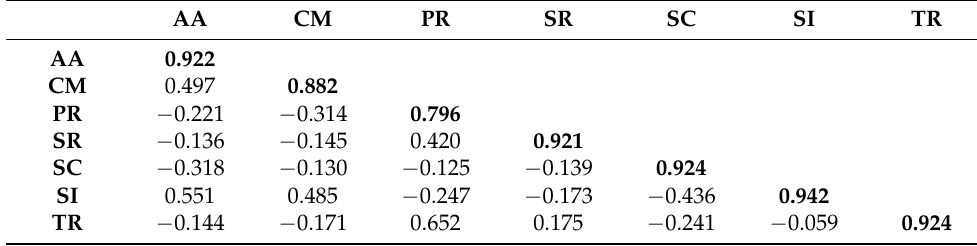
Table 2. Construct reliability and